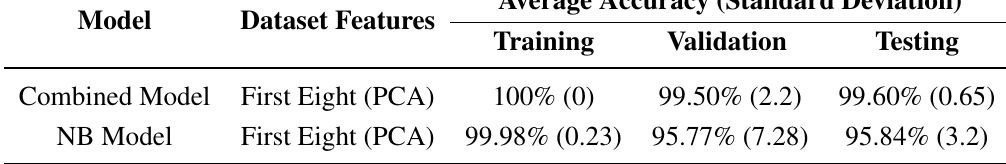
Table 3. Second model using Dataset-2 (8-d) performance profile along with a comparison to Naive Bayes model.